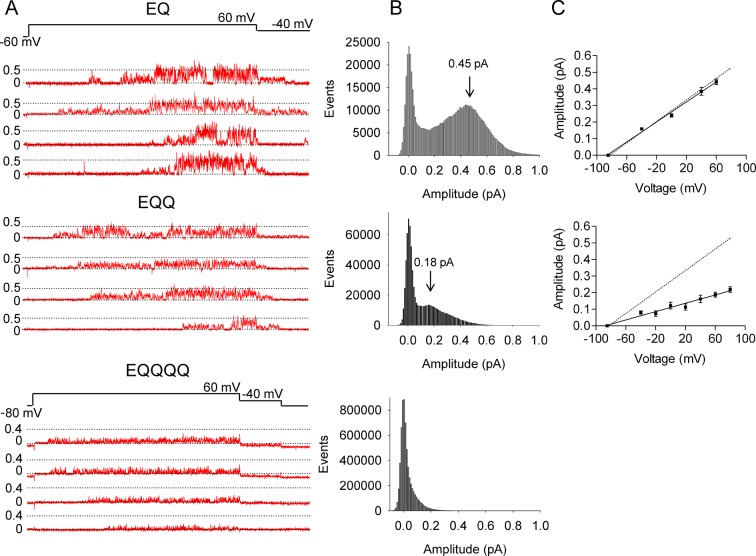
EQ, EQQ and EQQQQ show clear differences in single channel behavior.Membrane patches containing a single IKs channel made up of EQ, EQQ, or EQQQQ were stepped from a holding potential of -60 mV (-80 mV for EQQQQ) to 60 mV for 4 s and then to -40 mV for 0.75 s as indicated in the protocol at top. (A) Representative traces of single channel recordings from cells expressing EQ (top), EQQ (middle) or EQQQQ (bottom). (B) All-points amplitude histograms of only the active single channel sweeps from a file of 100 sweeps, blank sweeps were removed to limit the 0 amplitude peak. All-points amplitude histograms containing all the blank sweeps are presented in Figure 2—figure supplement 1. For EQQQQ the histogram represents data from 3 cells. Arrows indicate the peak conductance as determined by Gaussian fits using Clampfit. (C) The peak open amplitudes for several voltages were plotted with an extrapolated K+ channel reversal potential to derive a slope conductance for each construct. The slope conductance for IKs made up of unlinked KCNE1 and KCNQ1, as previously published, (Werry et al., 2013) is indicated by a dashed line. Amplitudes for EQQQQ were too small to make analysis of conductance meaningful.